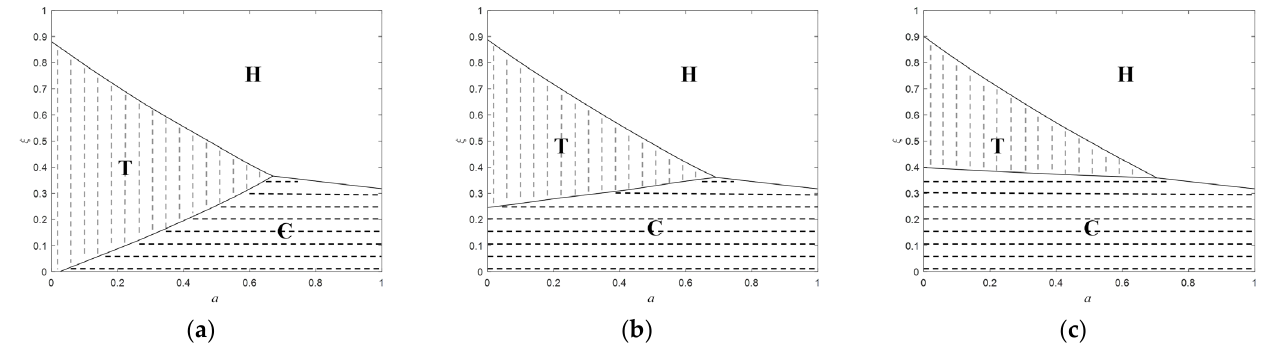
Figure 3. Return policy selection of brand under medium commission rate. ( a ) δ = 0.6; ( b ) δ = 0.75; ( c ) δ = 0.9.